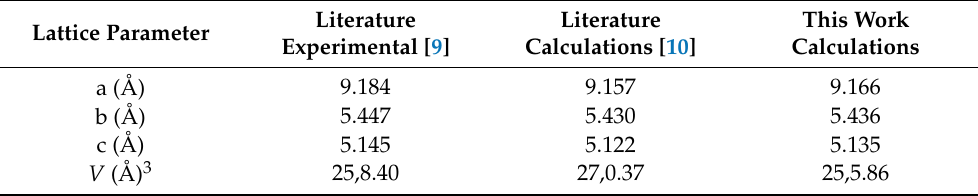
Table 1. Calculated lattice parameters for bulk brookite TiO 2 compared with experimental and previous theoretical results.